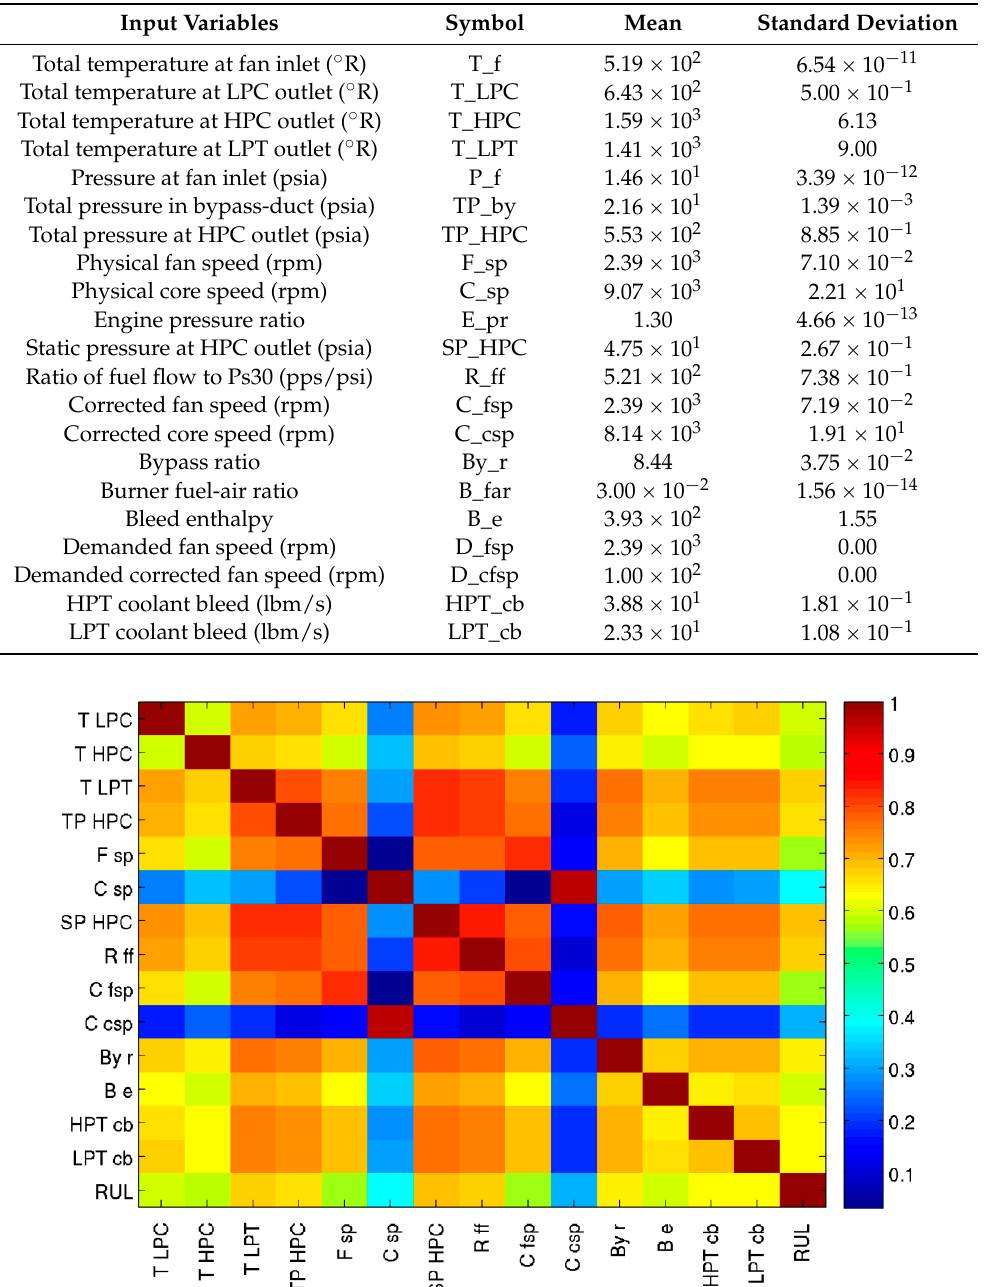
Table 1. MAPSS input variables of the simulated engine to simulate the remaining useful life (RUL) with their mean and standard deviation.